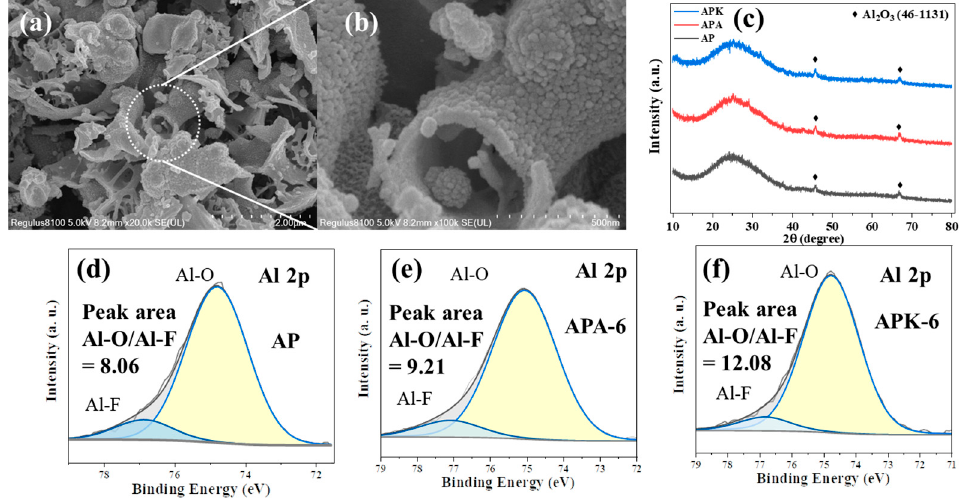
Figure 10. SEM images ( a , b ) and XRD images ( c ) of n ‐ Al/PVDF combustion products; Al 2p XPS refined spectra of combustion products of samples AP ( d ), APA ‐ 6 ( e ) and APK ‐ 6 ( f )